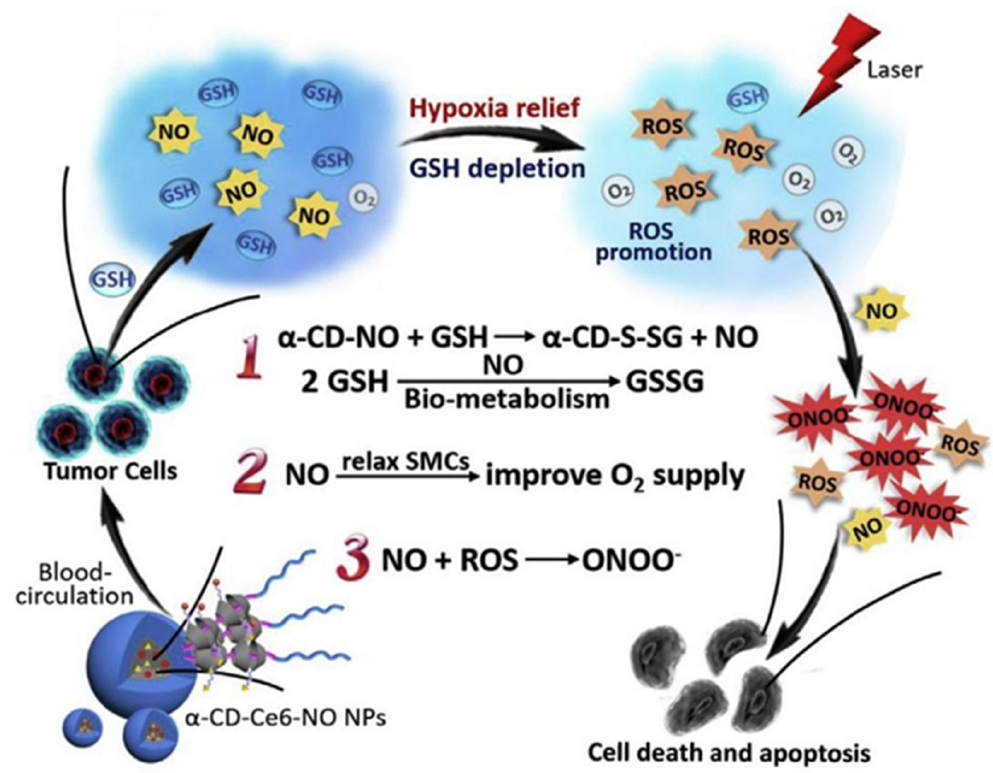
Figure 5. GSH-sensitive supramolecular nitric oxide (NO) nanogenerator (reproduced with permis- sion of Elsevier from ref. [53]).